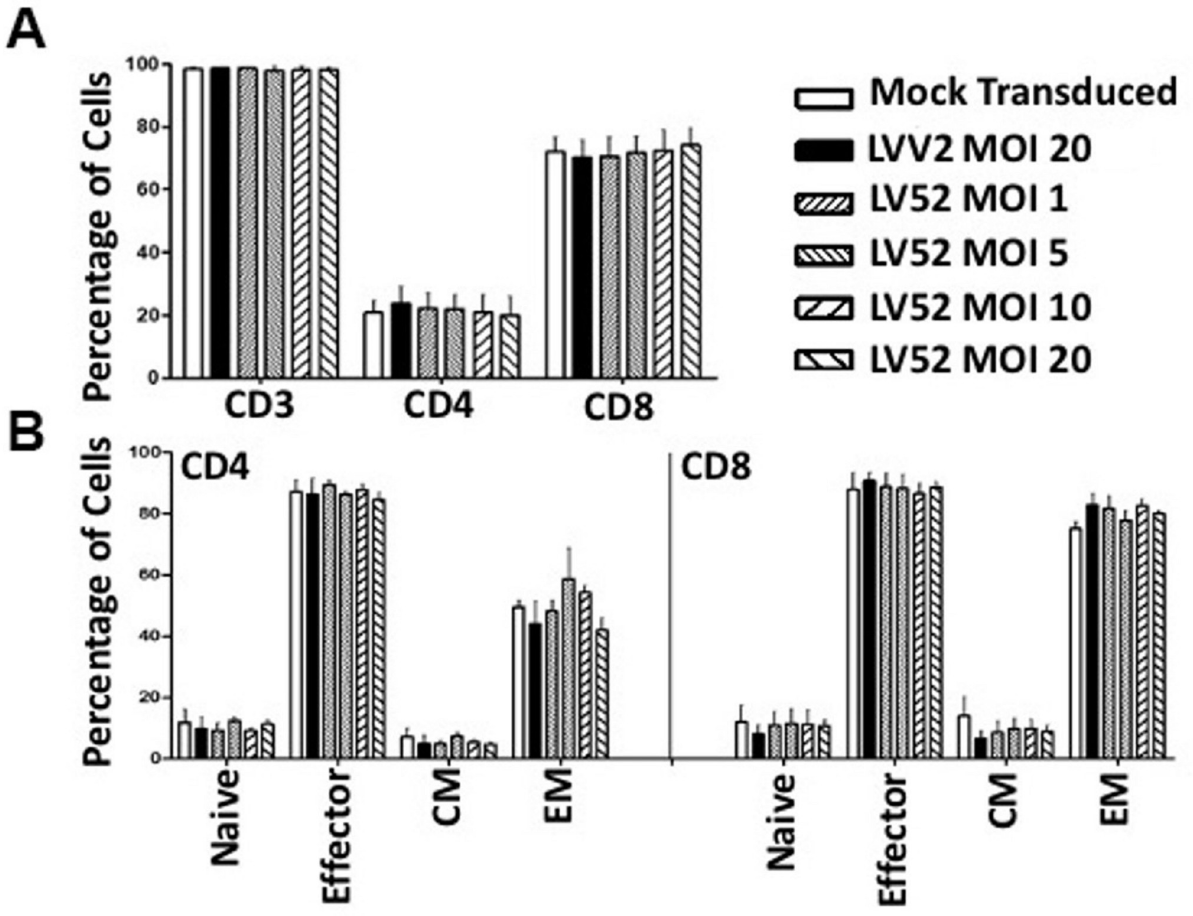
Fig 2. The phenotype of LV52 transduced cells. PBMCs from 3 donors were transduced as indicated and immuno-phenotyped by multicolor flow cytometry. (A) The proportion of T cells (CD3), helper T cells (CD4), and effector T cells (CD8). (B) The proportion of T cell subsets with effector/ memory function within the CD4+ and CD8+ populations. The data shown are the mean ± SEM of 3 independent